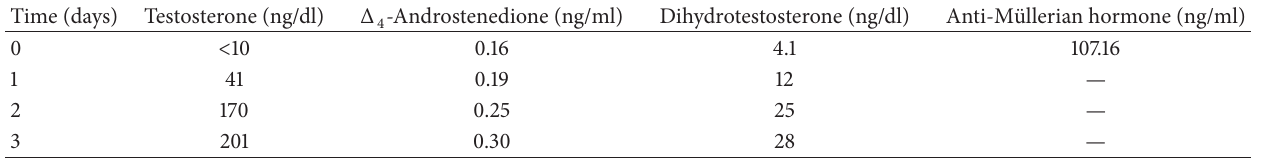
Table 3: hCG stimulation test in case